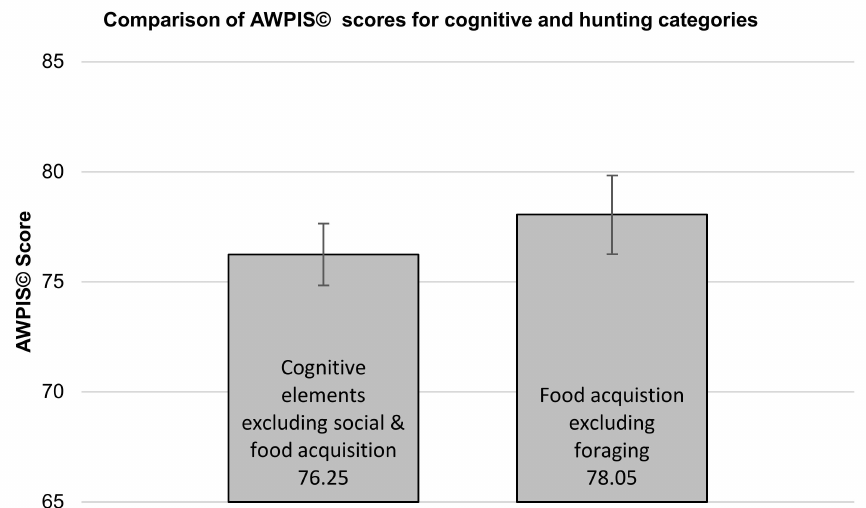
Figure 4. Comparison of group means ± standard error between cognitive processes and hunting-related behaviours, excluding social and foraging priorities (unpaired t-test; t(8) = − 0.793, p =